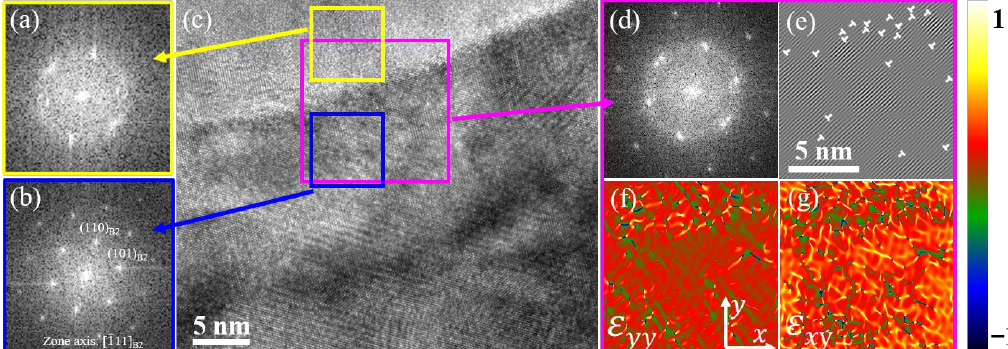
Figure 11. TEM observation of a grain boundary for the trained sample: ( a , b , d ) show the FFT patterns of the area indicated by yellow, blue and pink squares, respectively; ( c ) the HRTEM image; ( e – g ) show the IFFT patterns and GPA results of the area indicated by pink square.